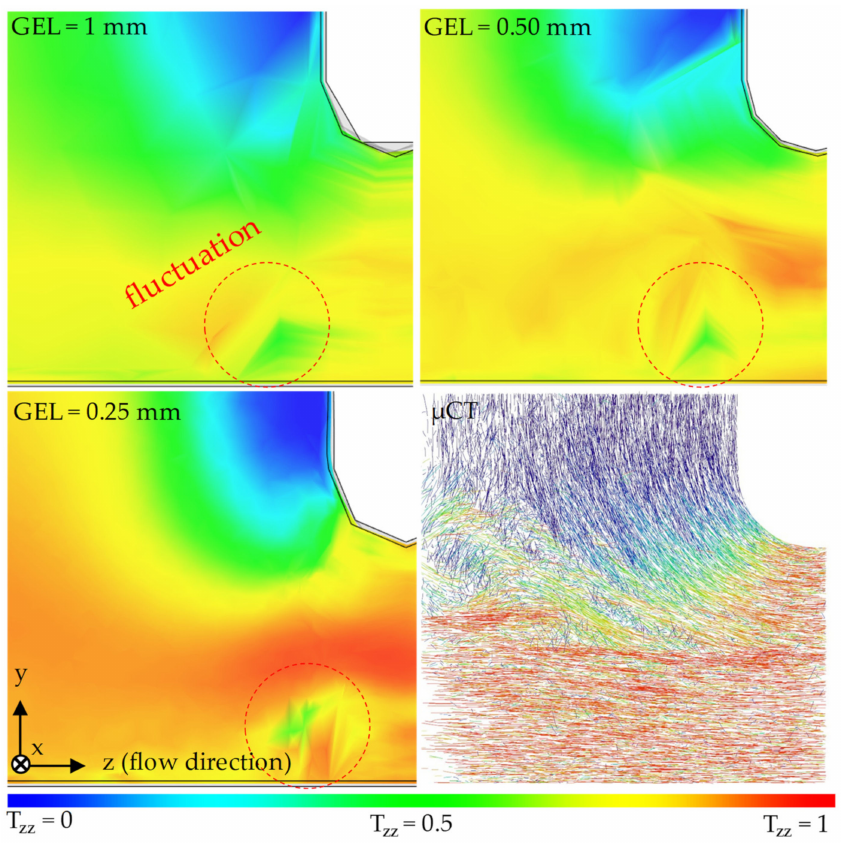
Figure 10. Qualitative comparison between the real fiber orientation characterized by µ CT and the fiber orientation predicted by the 3D mesh in region 2 under variation of the GEL along the YZ-plane.